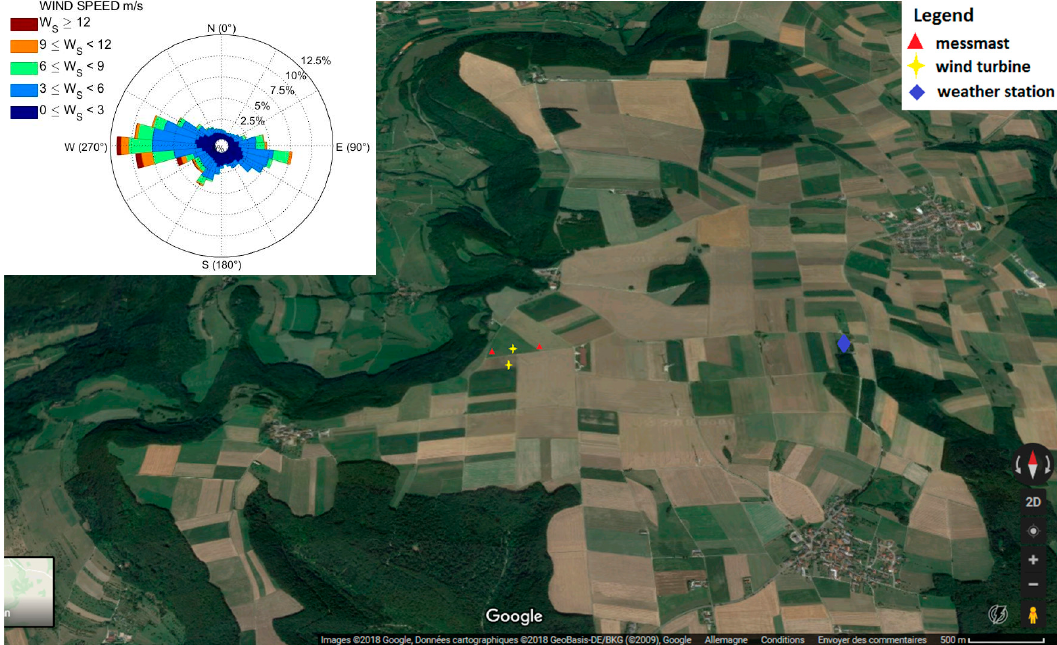
Figure 9. Overview of the test site and the wind rose generated from a cup anemometer at 10 m agl. at